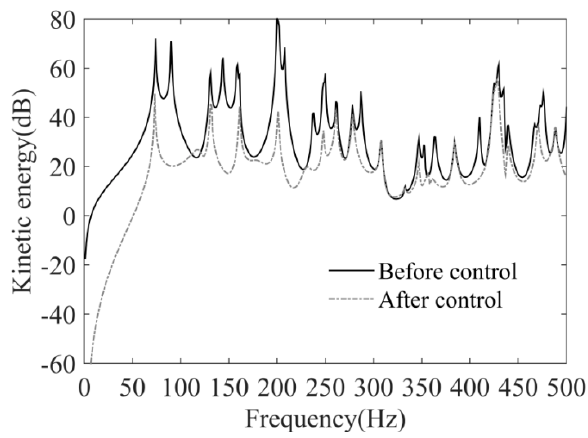
Figure 9. The kinetic energy of the ribbed plate B before and after control.